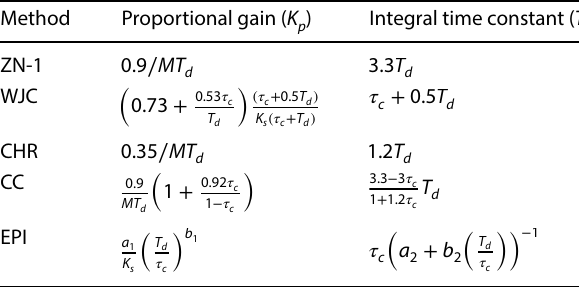
Table 5 Formulae to tune PIC by OLTR and EPI methods Method